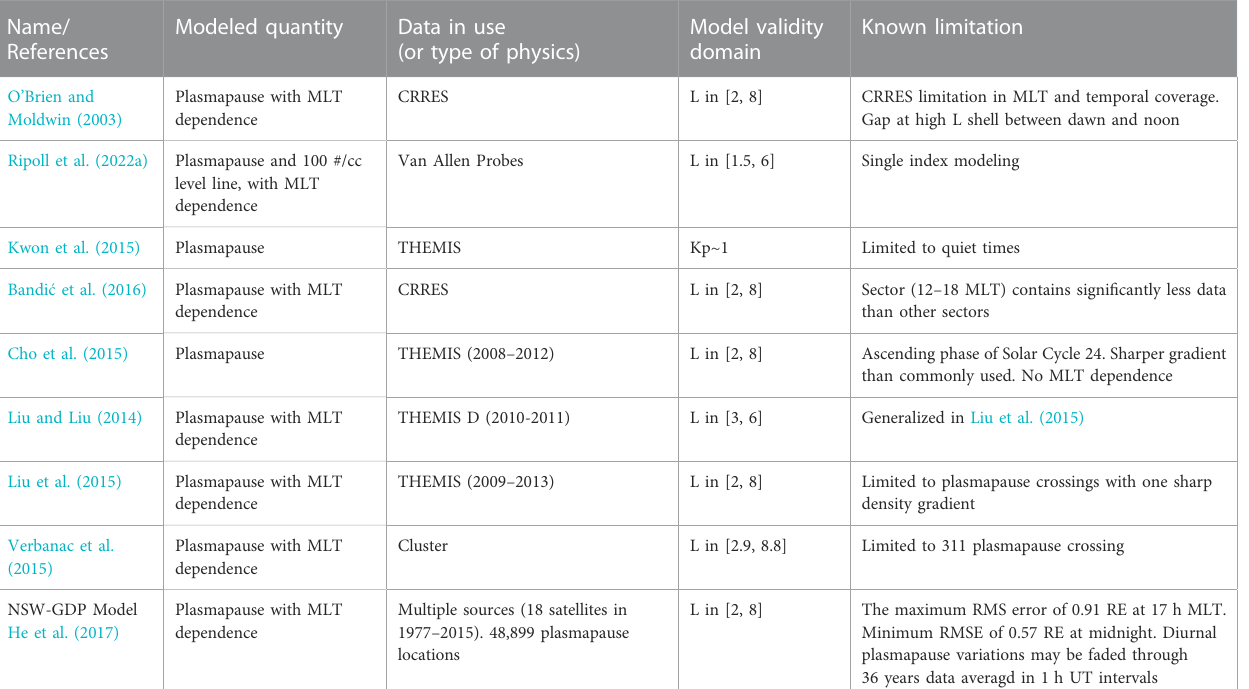
TABLE 2 Empirical plasmapause models discussed in this